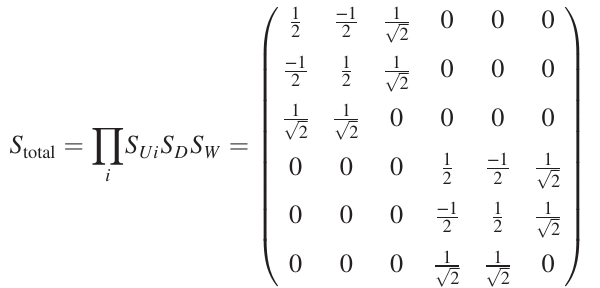
FIG. 5. Implementation of an arbitrary 2 × 2 transformation. The two green rectangles represent the unitary components W and U of the singular value decomposition. The diagonal part D , marked in yellow, corresponds to single-mode modulations by σ j , which are realized by coupling to ancilla